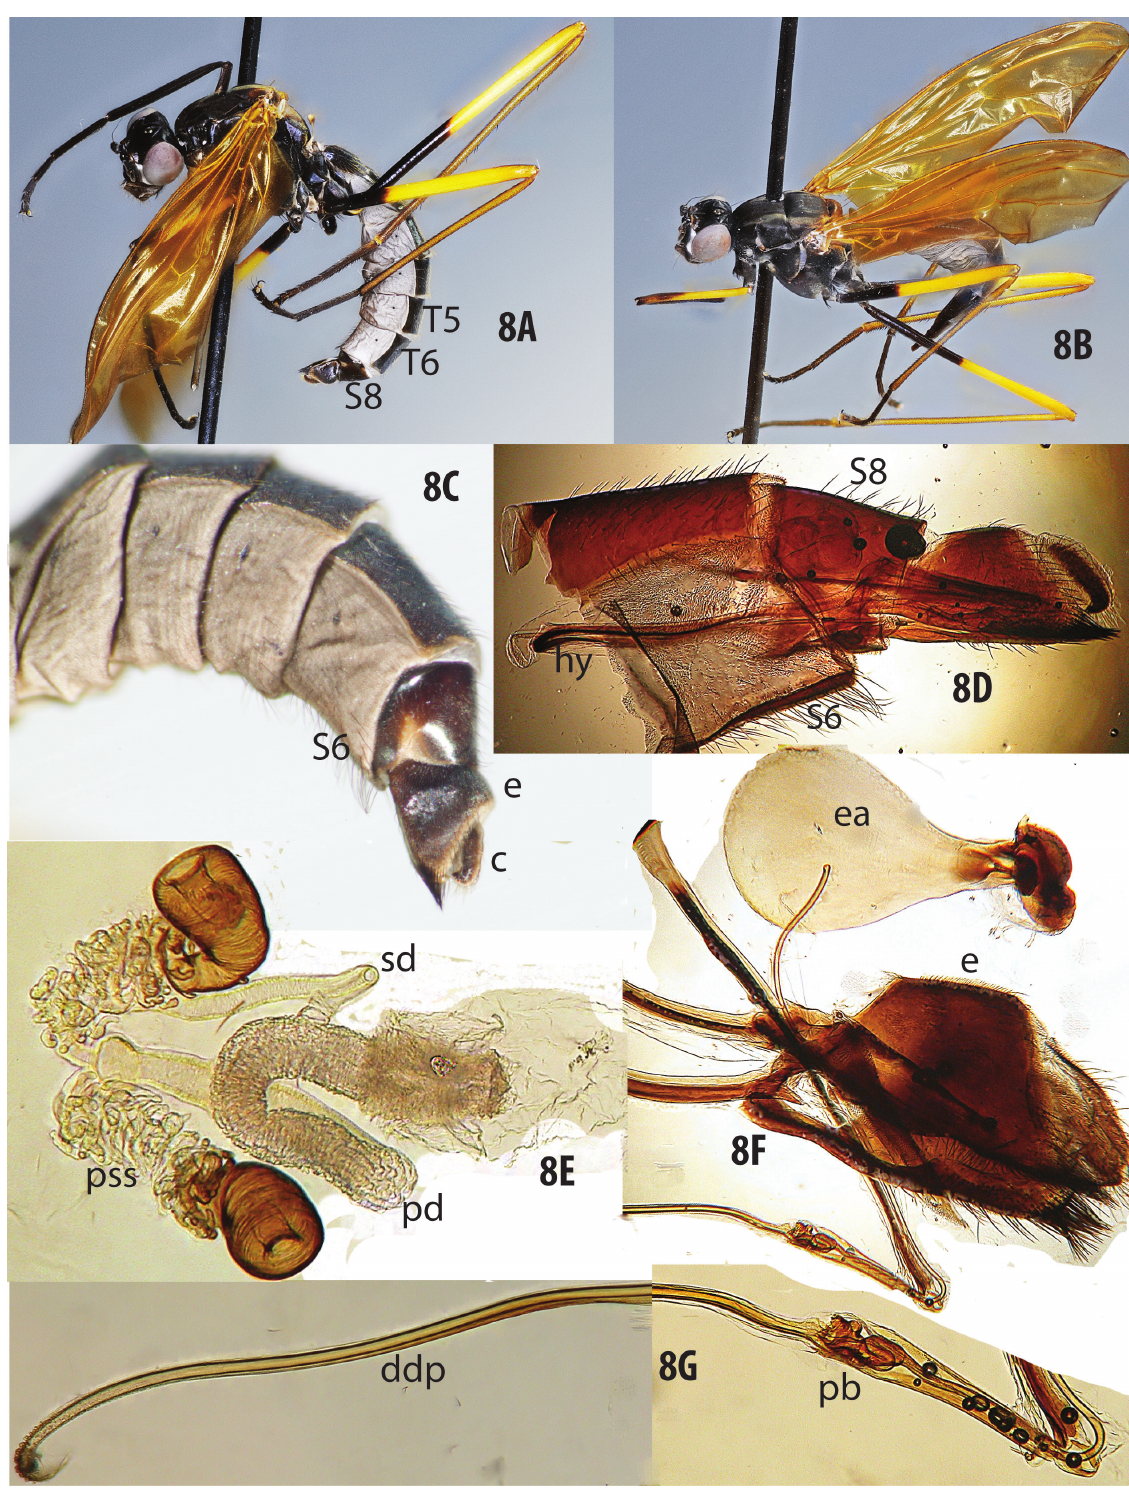
Fig. 8. Mesoconius epandribarba sp. nov . A . Holotype, ♂, IAVH. B . Paratype, ♀. C . Abdomen in lateral view, ♂. D . Male terminalia and abdominal segments 5–8. E . Spermathecae and associated structures. F . Male terminalia, left lateral view. G . Phallus, left lateral view. Abbreviations: c = cercus; ddp = distal distiphallus; e = epandrium; ea = ejaculatory apodeme; hy = hypandrium; pb = phallic bulb; pd = paired spermathecal duct; pss = paired spermathecal stem; sd = single spermathecal